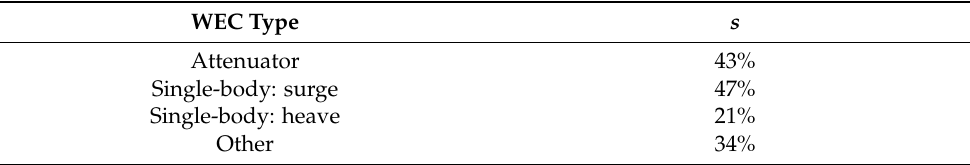
Table 7. Structure cost as proportion of total CAPEX for different WEC types based on values provided by WES developers. For a description of these WEC types see [35].